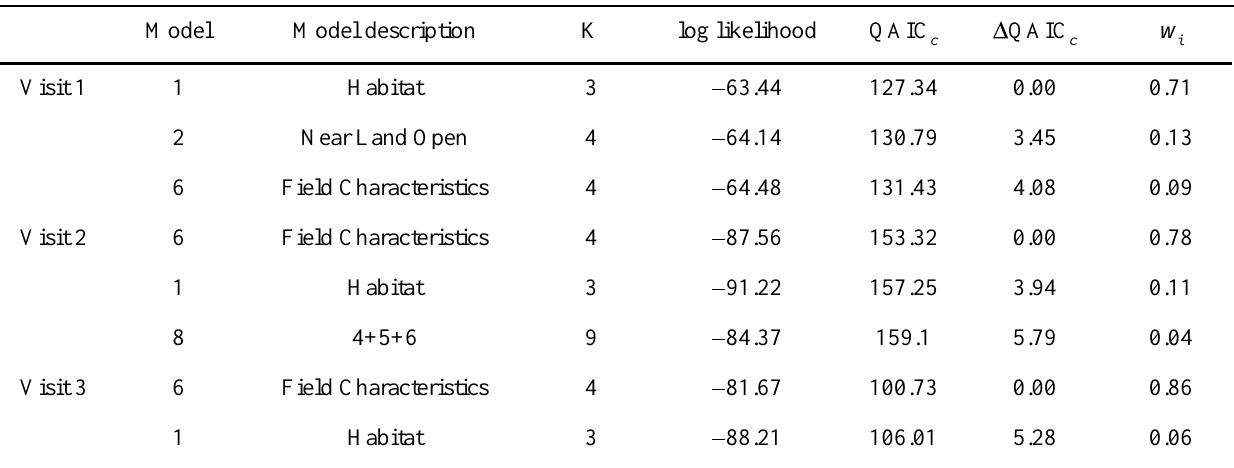
Table 7. QAIC rankings, number of parameters (K), log likelihoods, QAIC c ) for Poisson regression models reflecting habitat usage hypotheses for point count data on male Savannah ( w i Sparrow abundance conducted between May 21 and July 2, 2002 in the Champlain Valley of Vermont and New York. Only models included in the 90% confidence set are